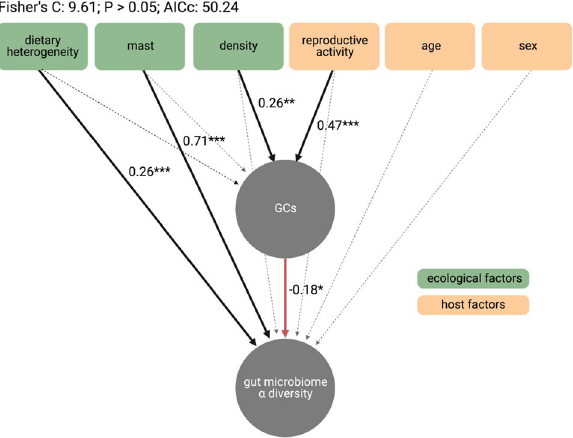
Figure 4. Ecology and host biology influence gut microbiome alpha diversity via changes in host glucocorticoids. Structural equation model assessing direct and indirect effects of ecological and host factors on glucocorticoids (GCs) and gut microbiome alpha diversity (Chao1 richness). Solid black arrows represent significant positive paths; solid red arrows represent significant negative paths; dotted arrows represent non- significant paths. Text labels indicate standardized beta estimates (i.e., effect sizes) and significance (P < 0.05*, P < 0.01**, P < 0.001***) for each of the predicted pathways tested in the